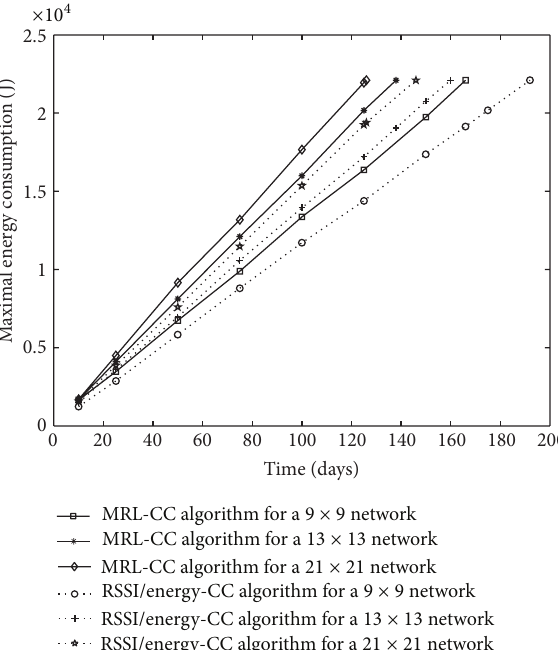
Figure 11: Maximal energy consumption in the whole WSN, com- parison between MRL-CC and E/RSSI CC algorithms for different network architectures.